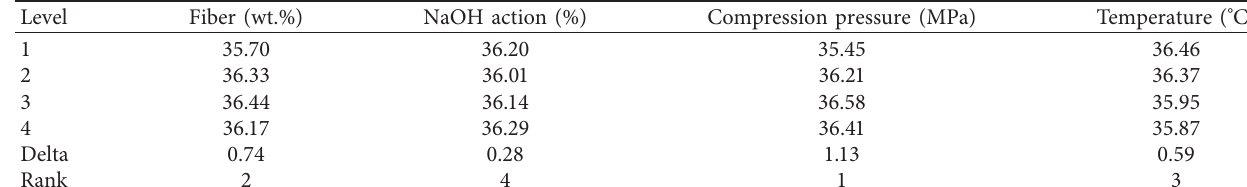
Table 10: Response table for signal-to-noise ratios (shore D hardness); larger is better.